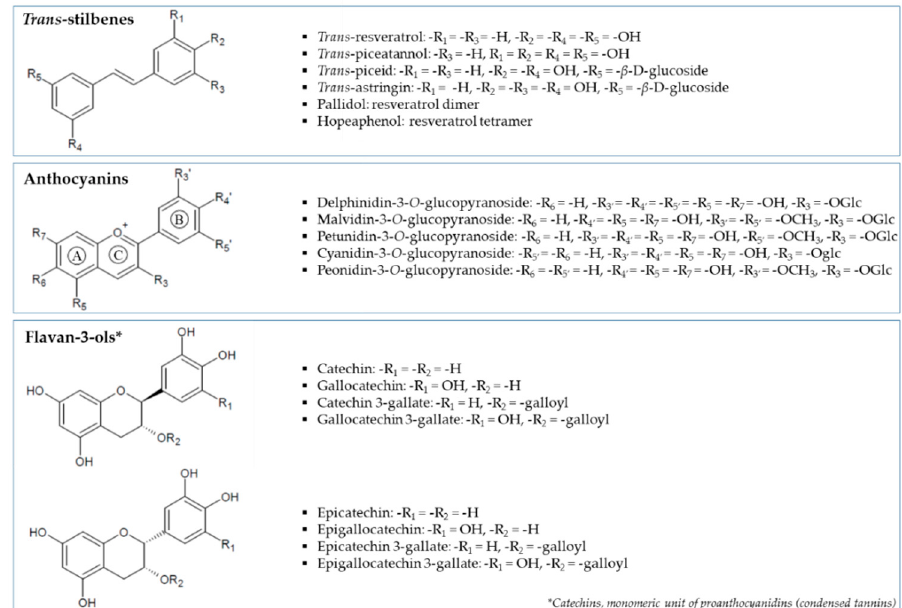
Figure 1. Structures of different polyphenol families and relative compounds identified in seed and skin grapes in the present work.